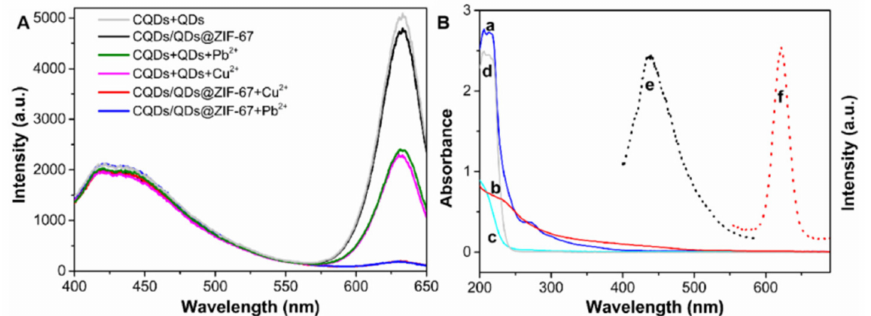
Figure 5. ( A ) Fluorescence spectra of the mixture of CQDs and QDs, and the CQDs/QDs@ZIF-67 composite in the existence or non-existence of a 300 nM Cu 2+ or 100 µ M Pb 2+ solution; ( B ) UV-vis absorption spectra of CQDs (a), QDs (b), Cu 2+ (c) , Pb 2+ (d) and fluorescence emission spectra of CQDs (e) and QDs